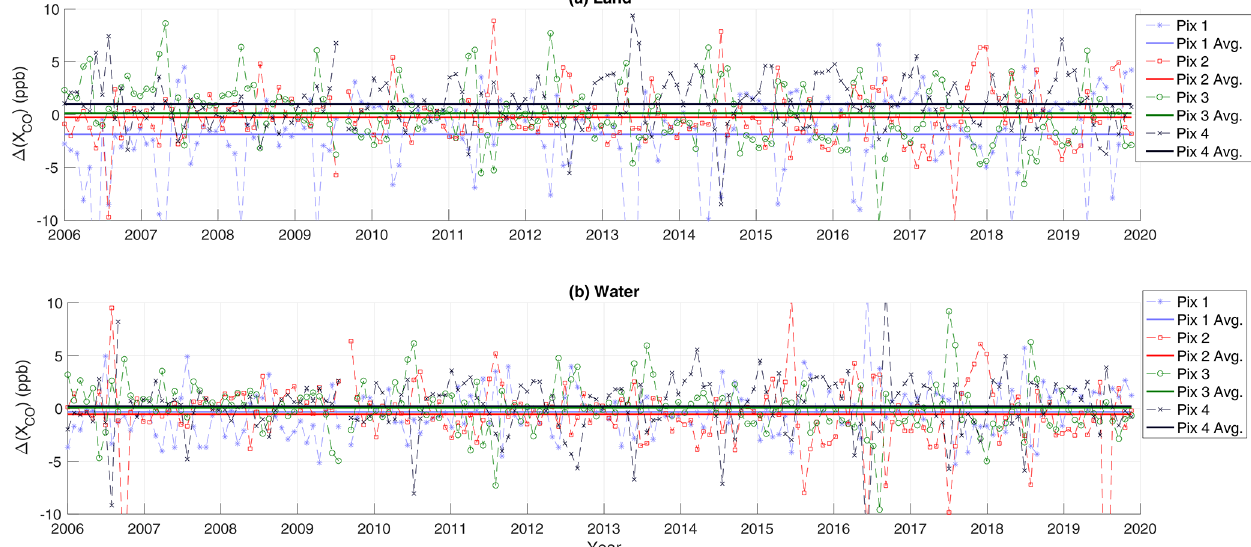
Figure 1. Individual MOPITT pixel biases, compared to the weighted mean of all pixels, over time for the joint TIR–NIR product. Symbols show 30d mean biases and thick lines show all-year averages for pixels 1 (blue), 2 (red), 3 (yellow) and 4 (black) over land (a) and water (b) .